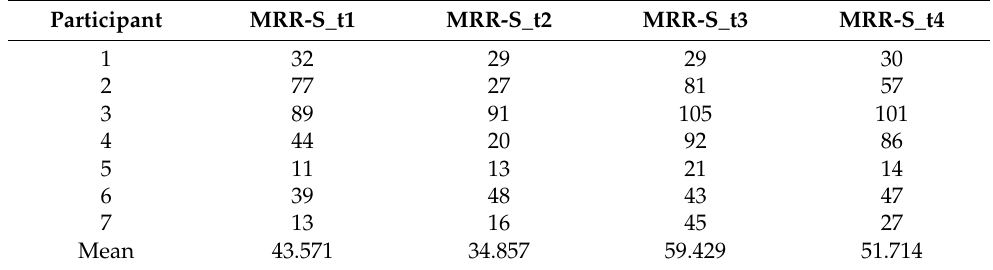
Table 13. MRR-S (syllables, total) individual and mean measurements at four assessment time points.